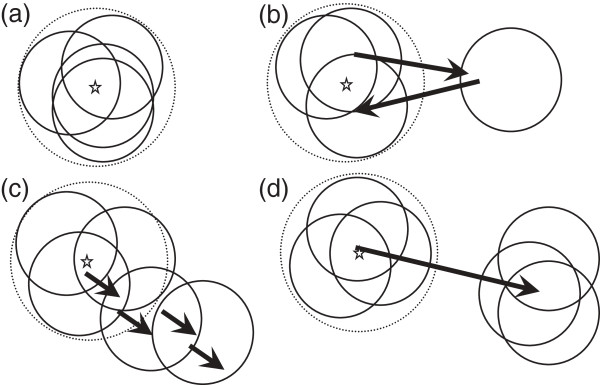
Typical types of space use in the European hare Lepus europaeus (following McShea & Madison [[28]]). Dashed circle: 588 m circle radius defining the home-range of origin; the centre of the home-range of origin (star) is the arithmetic centre of the first locations within the 588 m circle radius. (a) ‘Stationary’: each home-range (plain circles) overlaps previous estimates; (b) ‘Explorer’: quasi ‘Stationary but the hare makes short-time extra home-range forays with returns later on; (c) ‘Shifter’ disperser: the individual gradually leaves its home-ranges of origin; (d) ‘One-way’ disperser: the individual suddenly changes its home-range by making a one-way and permanent movement and settling in new disjunctive home-range.